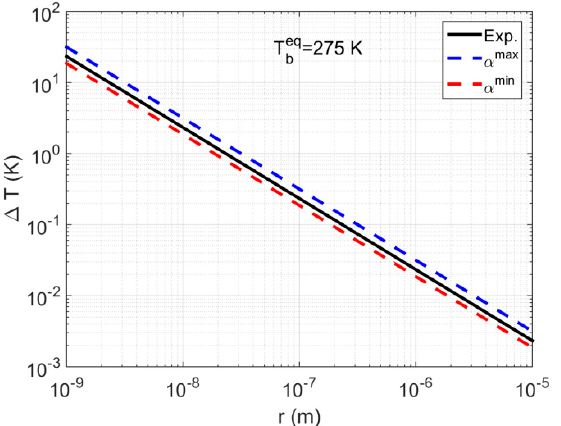
Figure 3. The effect of pore radius on the temperature depression (absolute) during methane hydrate dissociation in porous media. Results are shown for a temperature equal to 275 K. The solid line corresponds to the case of using variable parameters ρ s , ∆ H s , and γ sl , while the dashed lines correspond to the estimated minimum and maximum values for α , based on the fixed values for the parameters in Table 1.